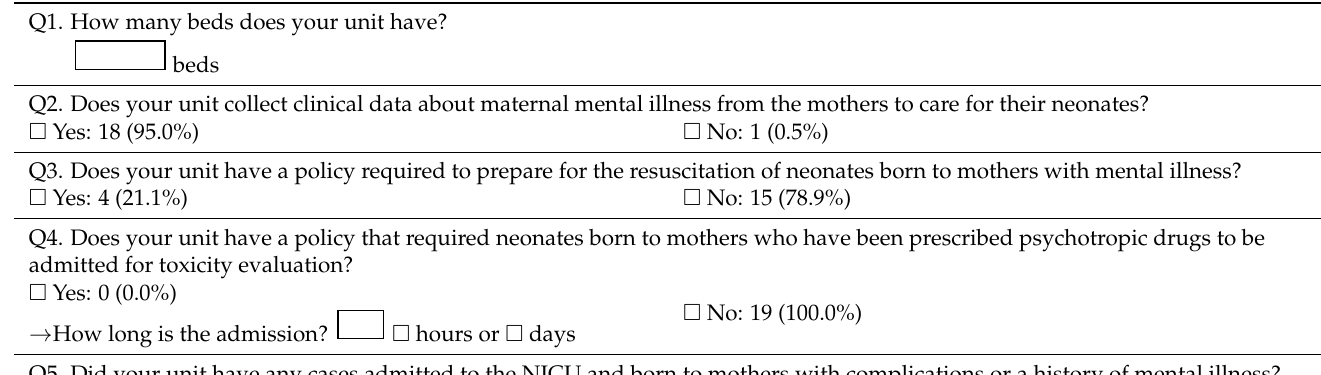
Table A1. Questionnaire for maternity care units. Table A2. Questionnaire for NICUs and answers. Table A2. Questionnaire for NICUs and answers.